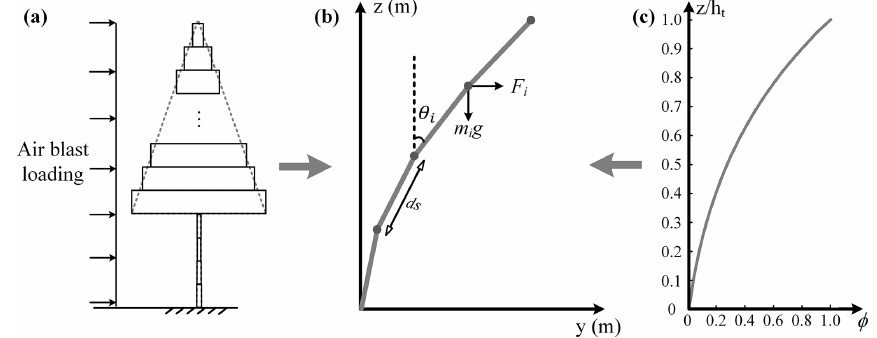
Figure 3. (a–b) Modeling the tree as a multi-degree-of-freedom flexible beam to calculate the dynamic response of trees subjected to a powerful air blast. (c) The first mode shape of the beam helps to model the tree deformation.